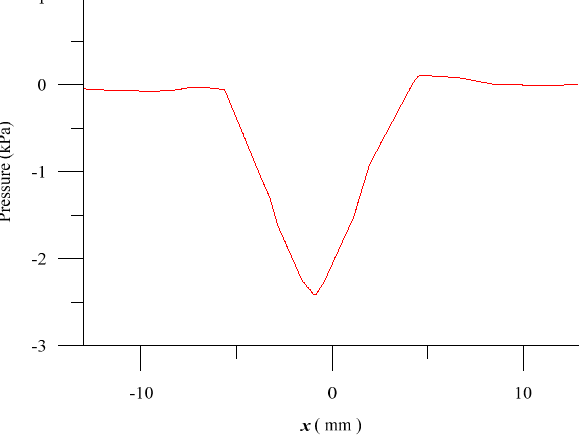
Figure 2. Numerical results of ( a ) pressure contours (section view) and ( b ) pressure profile (top section view of nozzle at 2 mm above surface of machining material) for gas inlet pressure of 300 kPa and gas outlet pressure of 30 kPa.